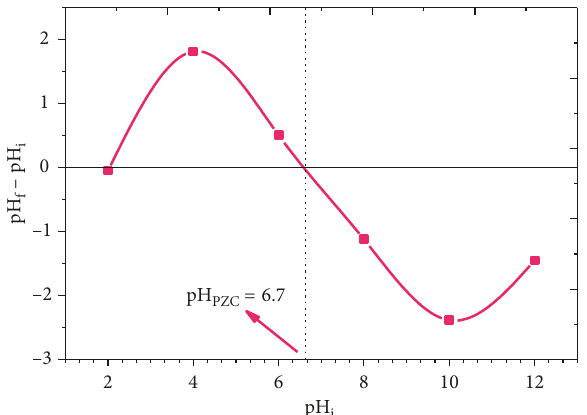
Figure 4: The point zero of charge of PB.